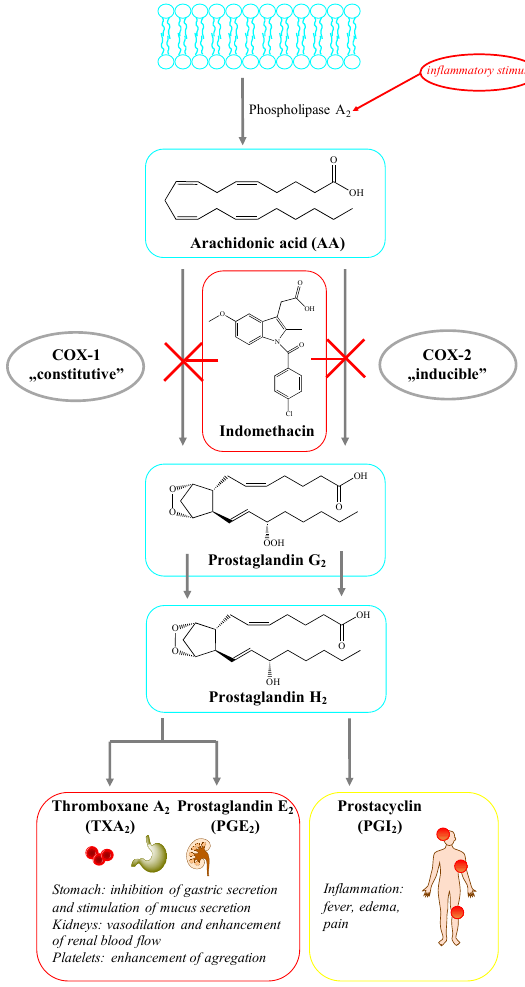
Figure 1. The mechanism of action of indomethacin.